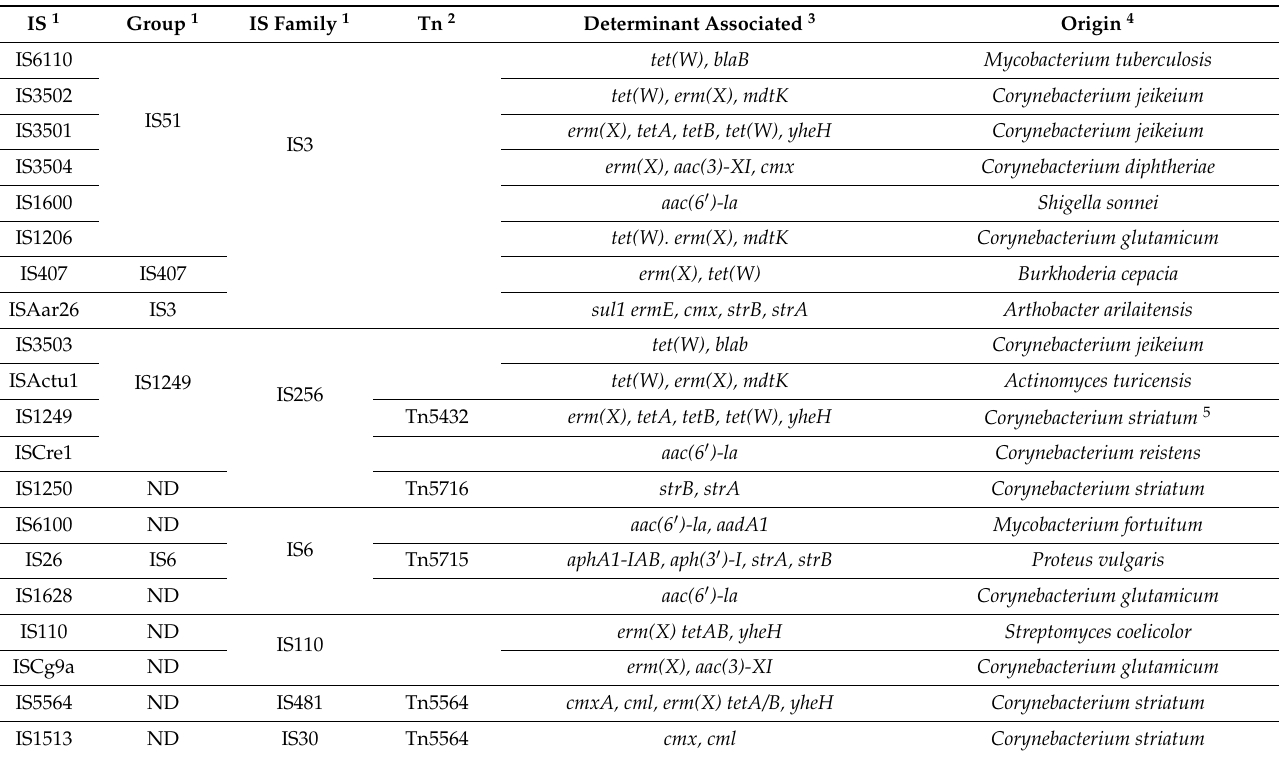
Table 1. Insertion sequences (IS) and composite transposons associated with resistance genes in C. striatum based on previous reports, ISfinder, and Tn registry web